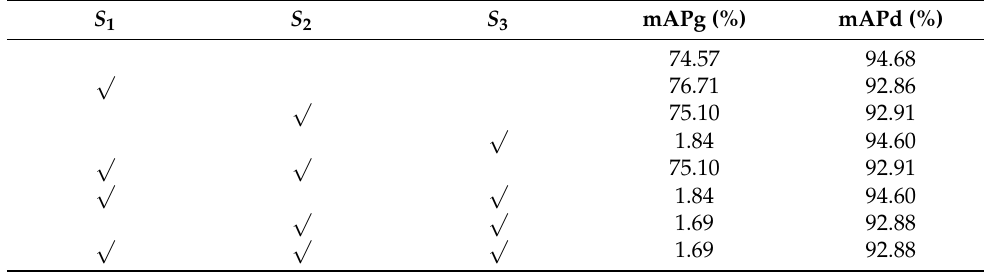
Table 3. Effect of Feature Refine Model at different stages.